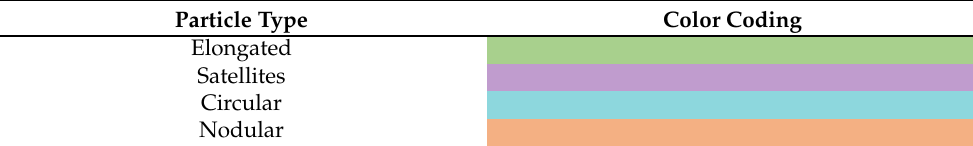
Table 8. Color Mapping for the predicted batch visualization of the defined classes.